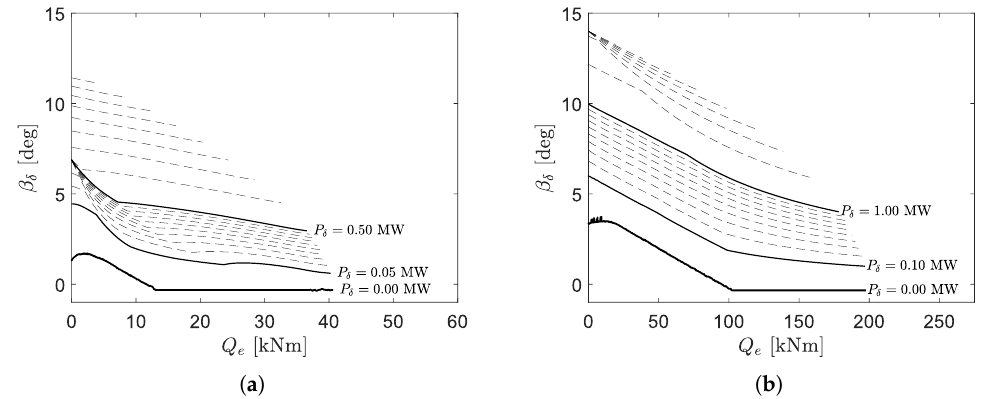
Figure 15. β δ ( Q e , P δ ) tables for NREL 5-MW ( a ) and DTU 10-MW ( b ) reference turbines.